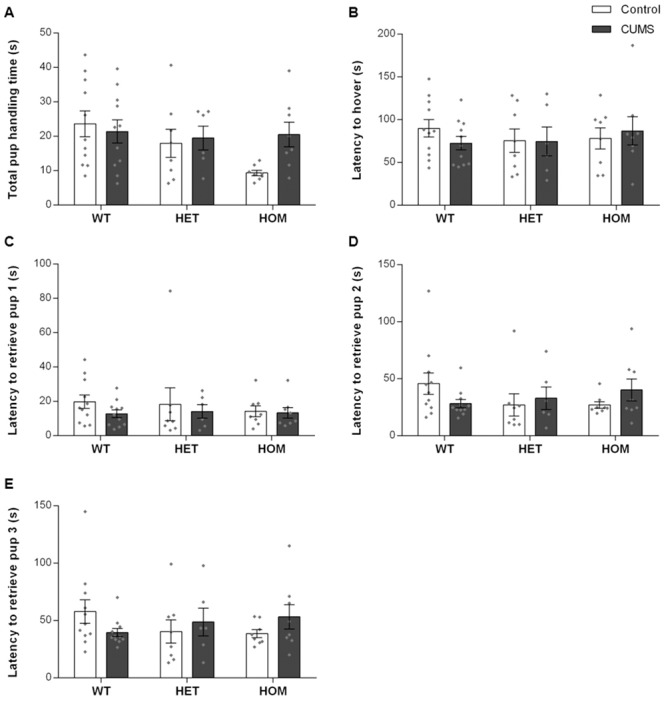
CUMS exposed did not alter pup retrieval responses in Shank3ex4-9 mutant dams.(A): Total time dams spent handling pups. (B): Latency for dams to hover over pups in the nest. (C, D, E): Latency for dams to retrieve their 1st, 2nd, and 3rd pups, respectively, and return them to the nest. CUMS exposure and genotypes did not affect any of the pup retrieval parameters. WT: Wildtype; HET: Heterozygous; HOM: Homozygous. N = Control (11 WT, 8 HET, and 8 HOM) and CUMS (12 WT, 6 HET, and 8 HOM). Individual data points are represented by diamonds.